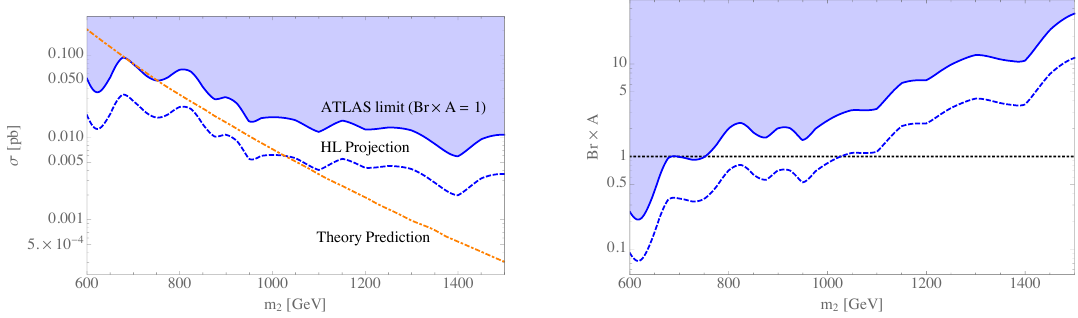
Figure 7 . Left: ATLAS excluded (shaded) and projected future limit (dashed) on dijet production cross-section assuming 100% acceptance and branching ratio into dijets, along with theoretical pro- duction cross-section (dot-dashed). Right: corresponding current excluded (shaded) and future limit (dashed) on the Br A . Maximum possible value Br A = 1 shown as dotted line to guide the (cid:2) (cid:2)